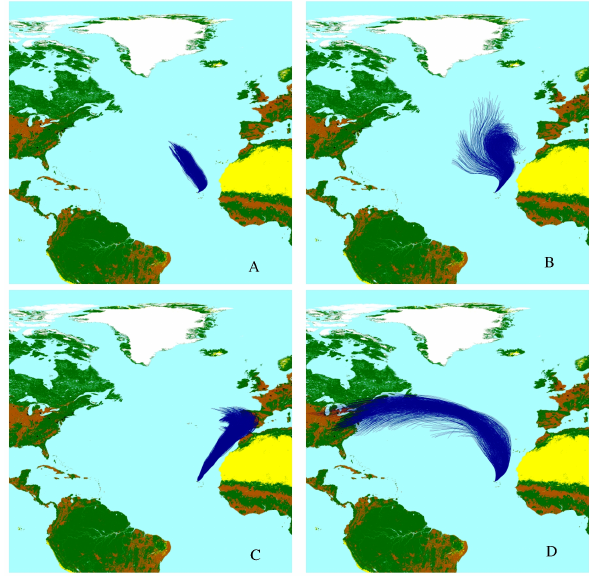
Fig. 3. Examples of 96 h air mass back trajectory ensembles ar- riving at CVAO. The blue, yellow, green, and brown colors rep- resent ocean, arid, vegetation, and agricultural landscapes, respec- tively. (A) 2 May 2011: Atlantic marine. (B) 23 May 2009: Marine over Canary Islands. (C) 4 June 2007: Marine from Europe. (D) 5 February 2009: Marine air mass from North